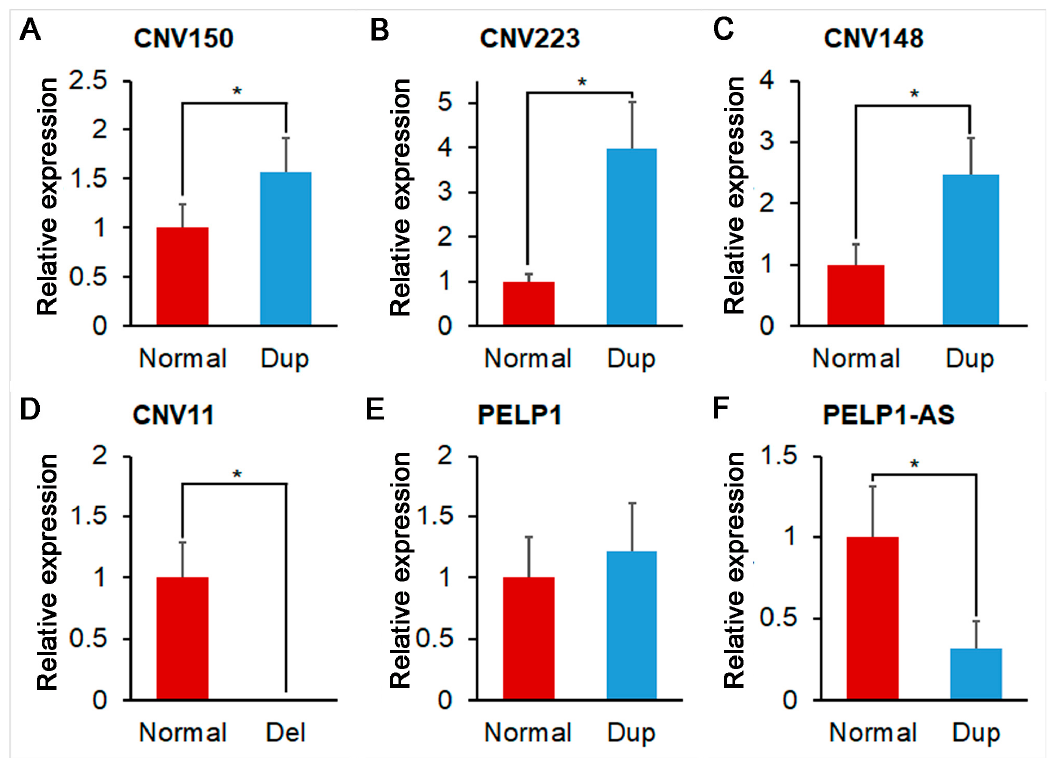
Figure 3. Relative expression of validated CNVRs and alternative splices of PELP1. ( A ) Relative expression of normal and duplicate (Dup) status of CNV150; ( B ) Relative expression of normal and duplicate (Dup) status of CNV223; ( C ) Relative expression of normal and duplicate (Dup) status of CNV148; ( D ) Relative expression of normal and deletion (Del) status of CNV11; ( E ) Relative expression of normal and duplicate (Dup) status of PELP1 alternative splice 1 (ENSSSCT00000075280); ( F ) Relative expression of normal and duplicate (Dup) status of PELP1 alternative splice 2 (ENSSSCT00000019507). * represents significant difference ( p < 0.05).